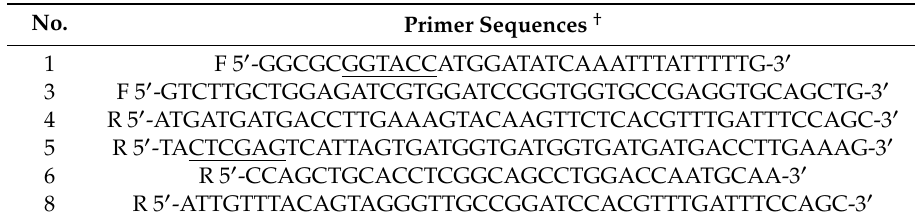
Table 2. Primer sequences used for PCR at creation of genetic